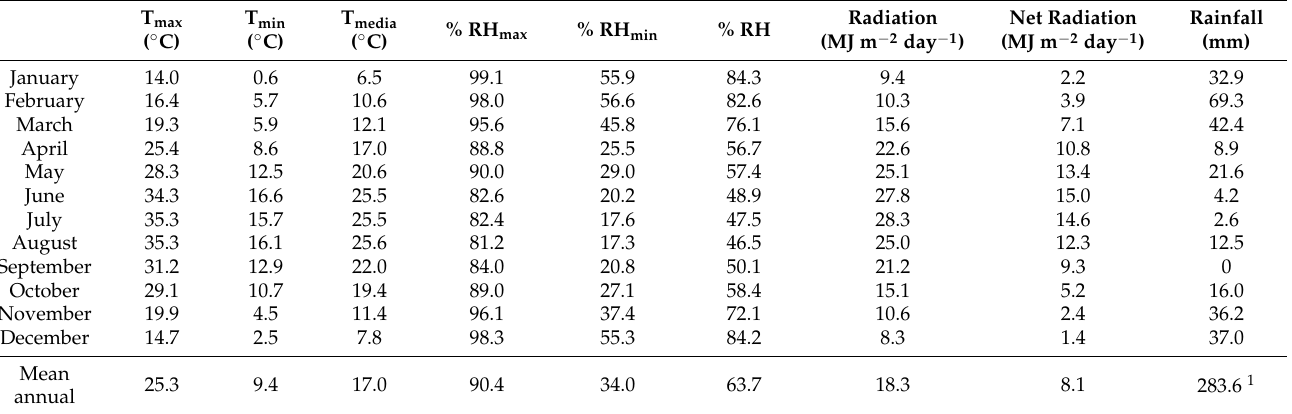
Table 1. Climatic conditions during the 2017 growth cycle. Monthly mean temperatures (T max , T min